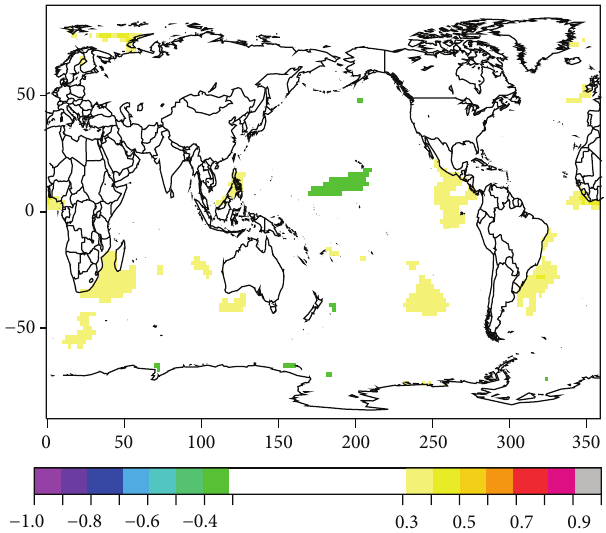
Figure 9: Pearson Correlation of the time series for the first mode of MAM season precipitation variability with ERSST sea surface temperatures.